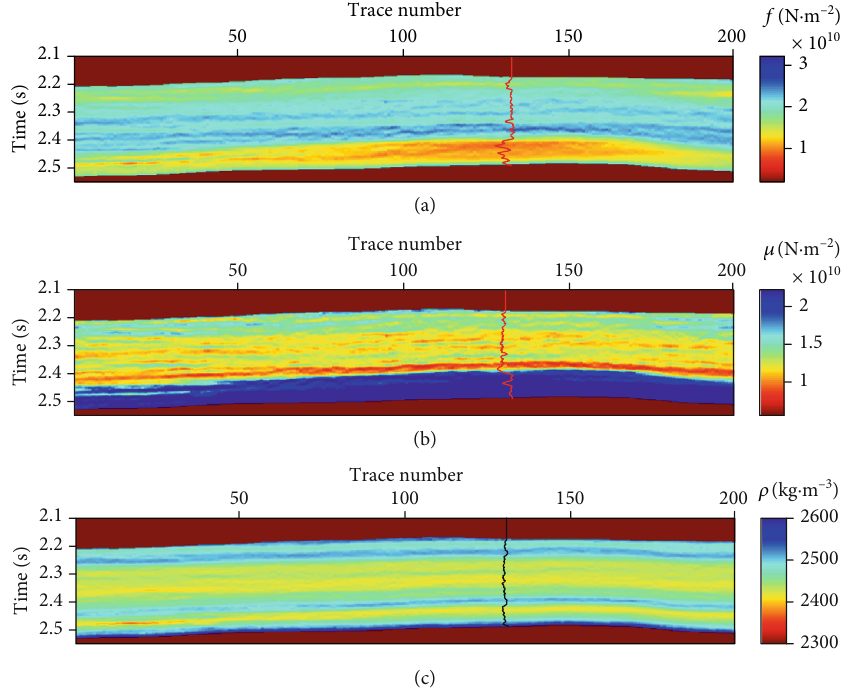
Figure 12: Inverted background fl uid and elastic parameters of a TTI medium, where (a) shows the fl uid/porosity term, (b) shows the shear modulus, and (c) shows the